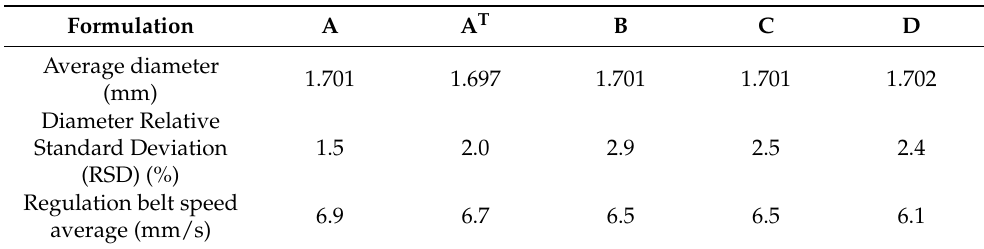
Table 6. Results of filament diameter by stericut measurement from left to right formulation A [41], A T , B, C and